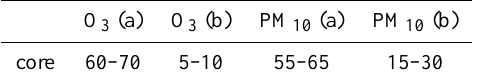
Fig. 4. Taylor diagrams of LR run vs. HR run (black symbols) and of LRn run and HR run (red symbols) for all species and for the 4 different regions. Panel (a) shows the results in the core, panel (b) in frame 1, panel (c) in frame 2 and panel (d) in frame 3.